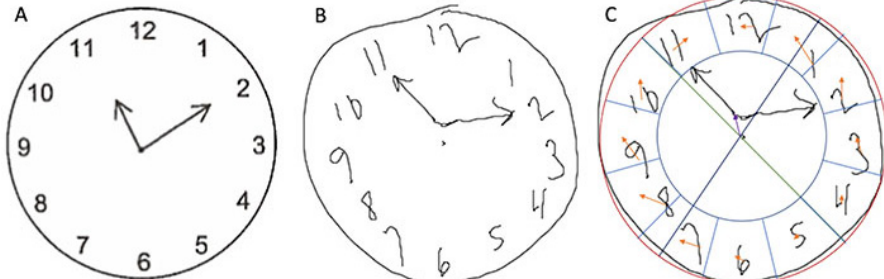
Figure 1. Participant copy condition clock drawing demonstrating hour hand distance from center and ideal digit placement difference. (A) Model clock presented to participants in the CDT copy condition; (B) drawing of a copy condition clock by a participant with longer-than-average length of stay (103.73 h) and cost of care ($ 211,159.88); (C) representation of hour hand distance from center and ideal digit placement difference for the participant’s clock. Red: circle of best fit; Green and dark blue: axes to identify center of circle; Purple: hour hand distance from center; Light blue: region for placement of each digit; Orange: distance of each digit from the ideal